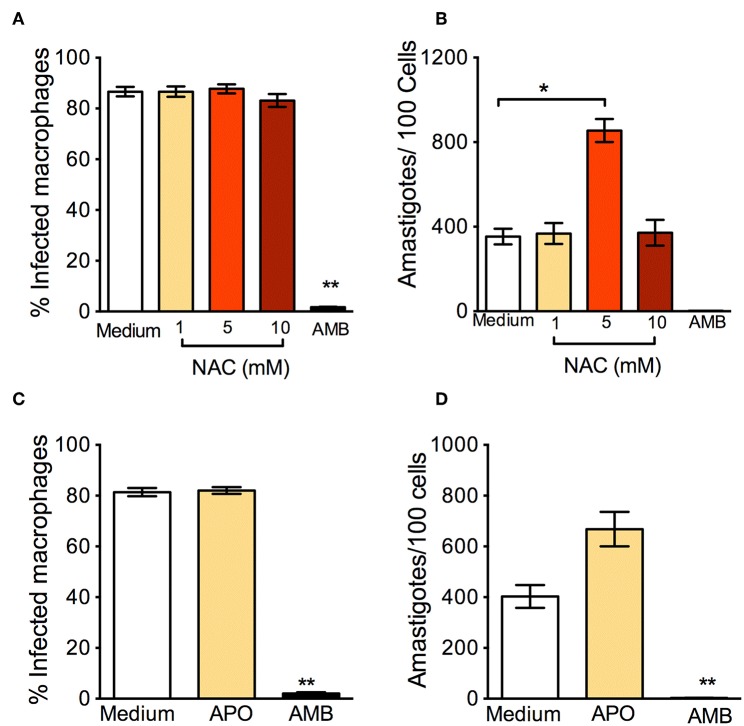
Anti-oxidants enhance in vitro infection with L. braziliensis. Macrophages were infected with L. braziliensis for 24 h, and then exposed to different concentrations of NAC (A,B) and Apocycin (C,D) for 48 h. Cells were stained with H&E and assessed for (A,C) the percentage of infected macrophages and (B,D) the number of amastigotes per 100 macrophages by optical microscopy. Infected macrophages treated with Amphotericin B (AMB) were used as positive controls. Data are shown as mean ± SEM. *p < 0.05, **p < 0.01, all comparisons were against negative control (medium).